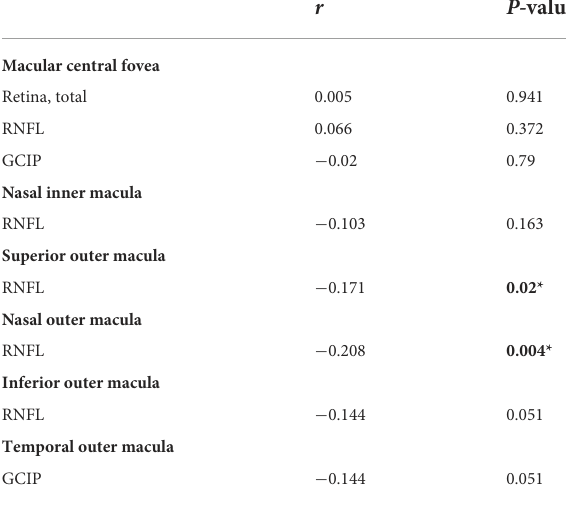
TABLE 5 Correlation analysis between white matter hyperintensity volume and retinal thickness.